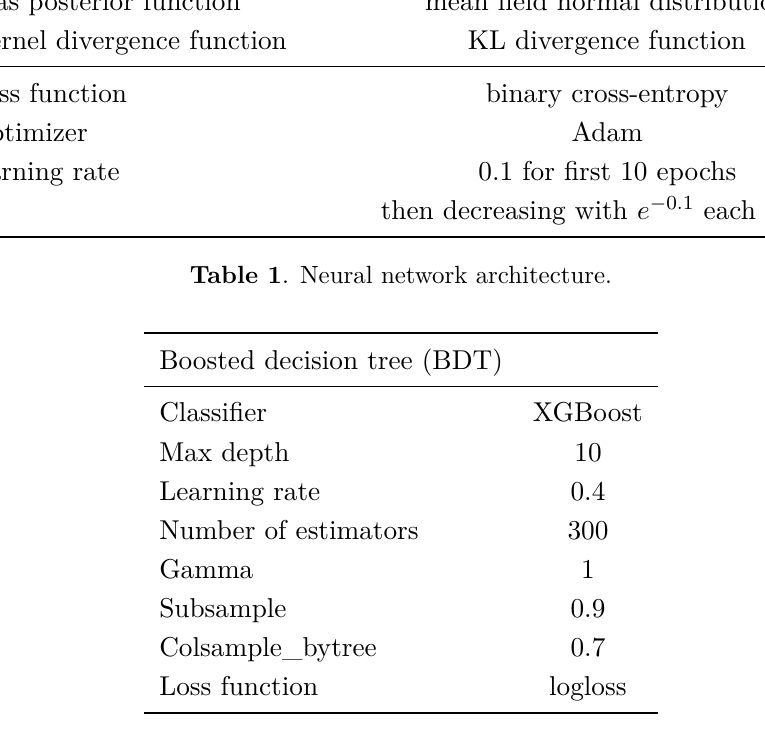
Table 2 . Boosted decision tree